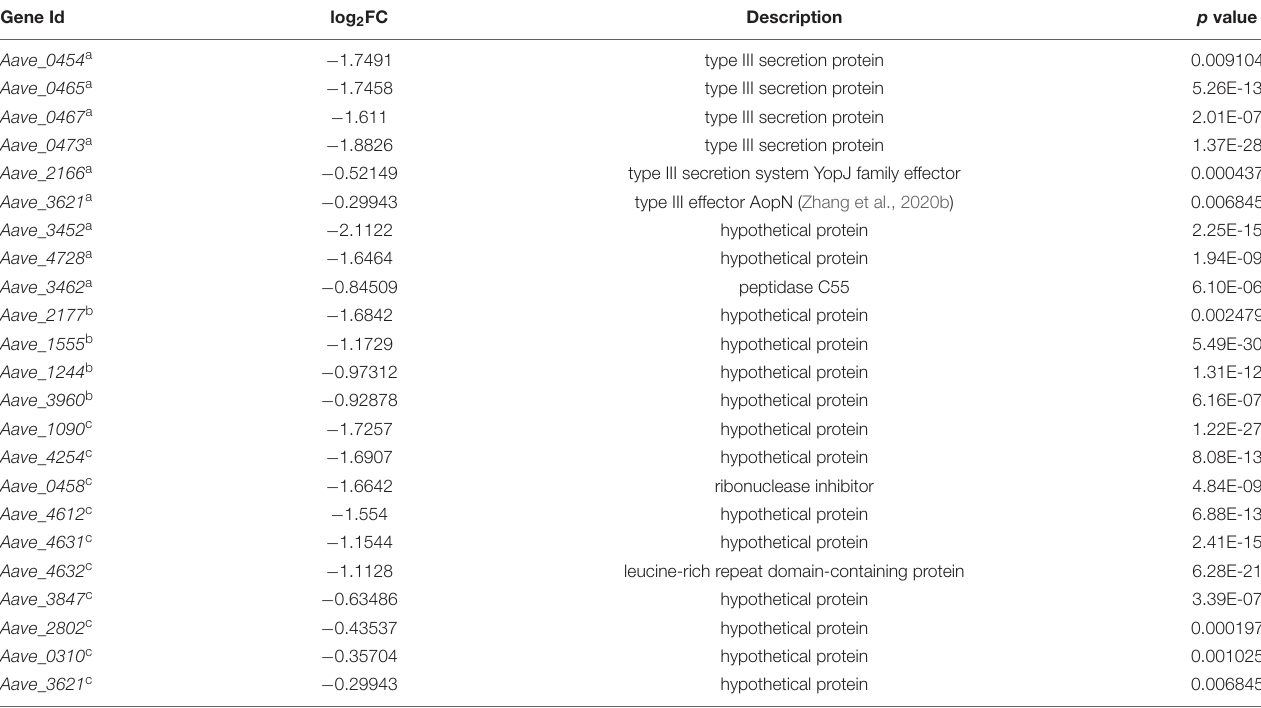
TABLE 2 | Differentially expressed genes related to type III-secreted